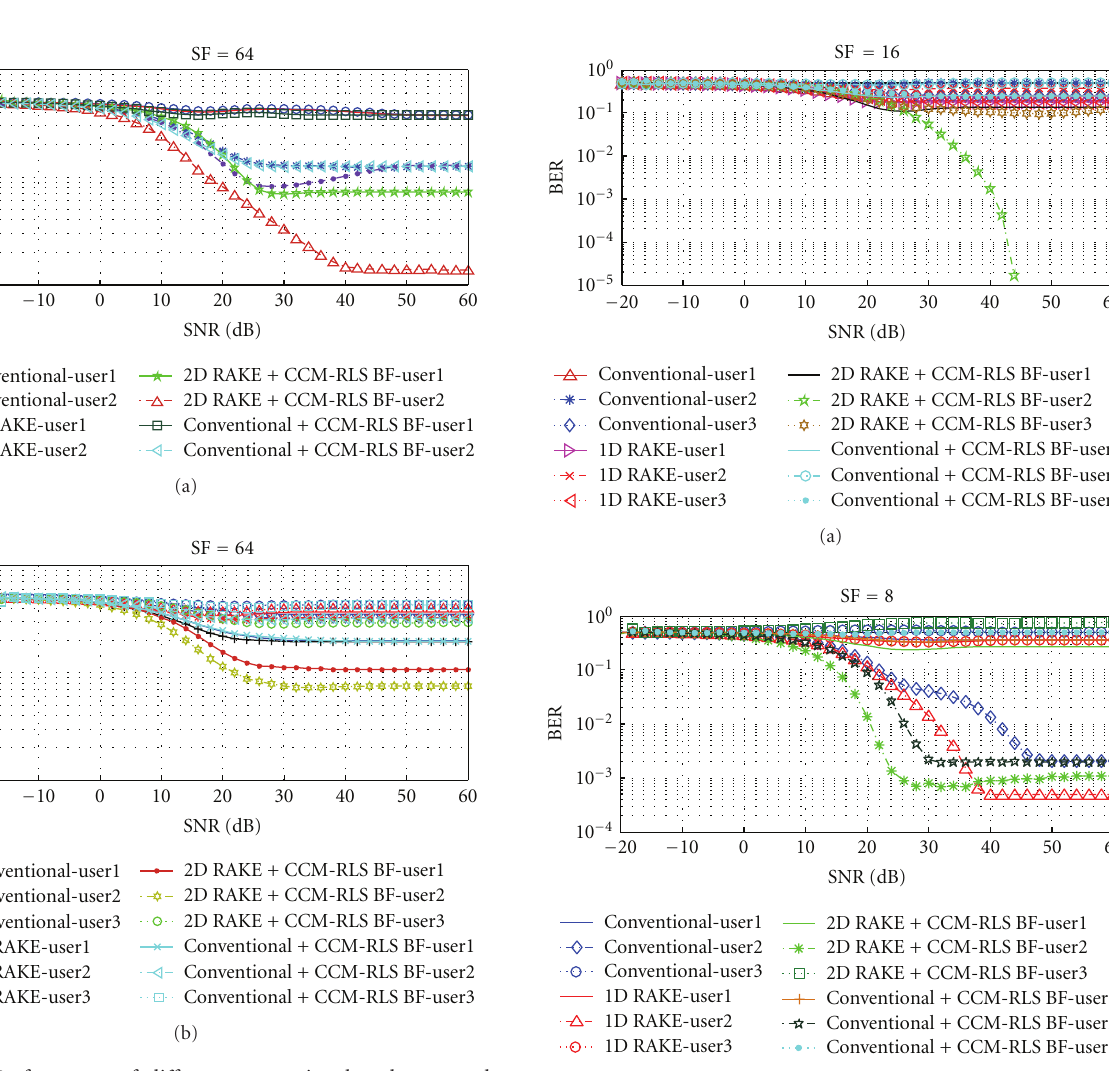
Figure 6: Performance of di ff erent conventional and proposed WCDMA receivers considering 4-element antenna array in 3-path AWGN fading channel for (a) 2 users, (b) 3 users. Figure 7: Performance of di ff erent conventional and proposed WCDMA receivers considering 4-element antenna array in 3-path AWGN fading channel with 3 users for (a) SF = 16, (b) SF =